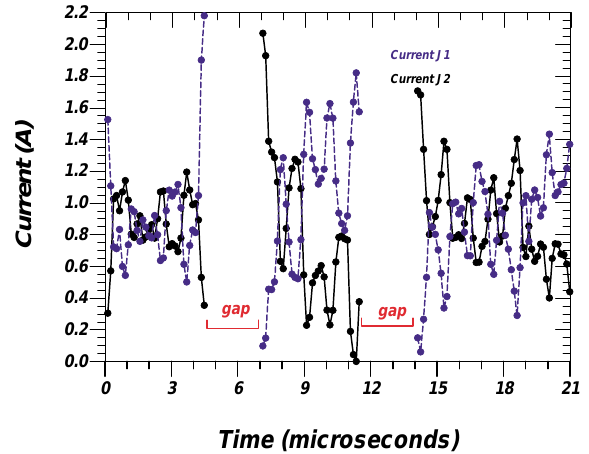
FIG. 4. (Color) Currents in the two electron lenses to compen- sate the bunch-to-bunch tune spread in the 140 3 121 bunches scenario; see text.